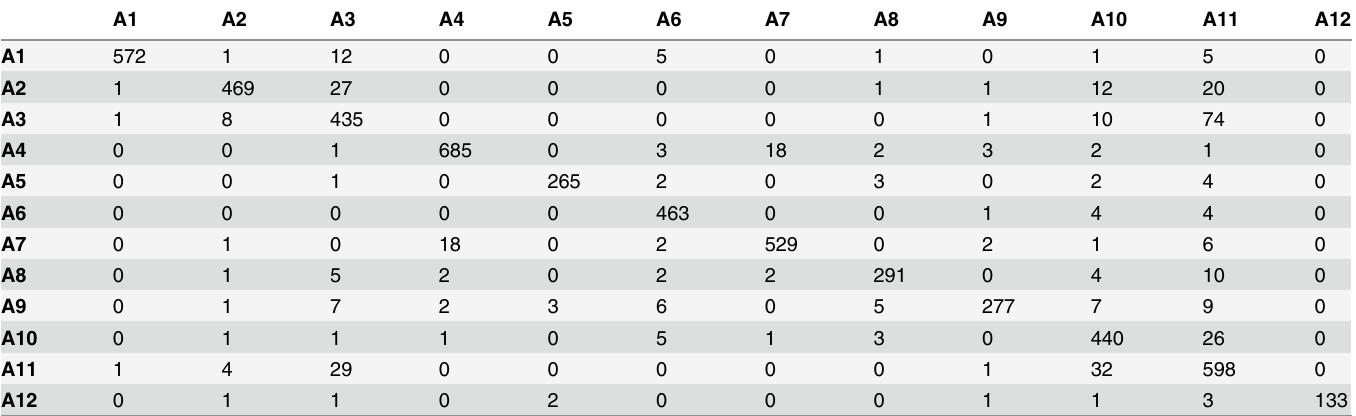
Table 7. Confusion matrix for rotation forest classifier (Acceleration sensor placed on